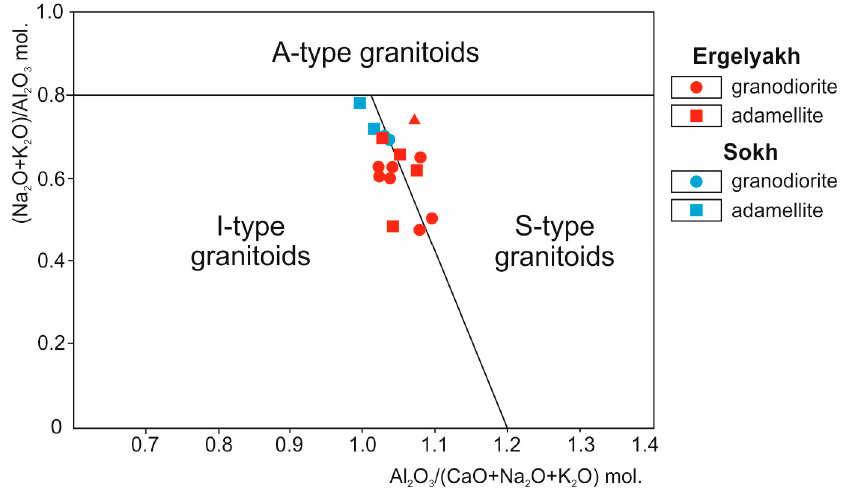
Figure 7. Petrogenetic types of the EIRGD granitoids [53].